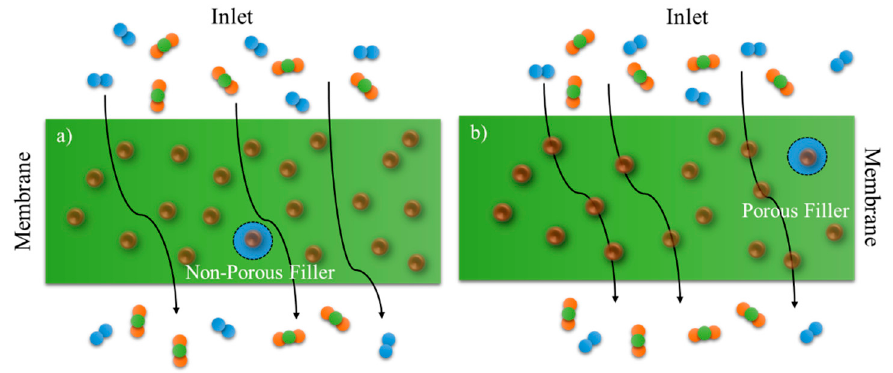
Figure 2. Transport mechanism with ( a ) conventional permeable particles and MMM ( b ) high aspect ratio.